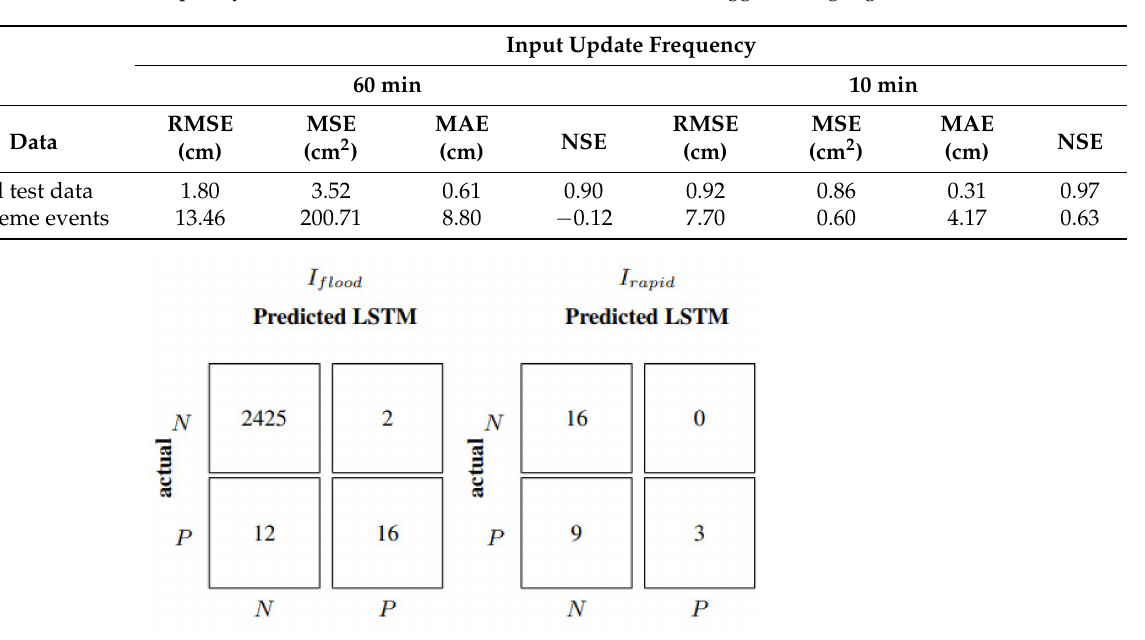
Table 8. Comparison of multivariable LSTM performances with 60- and 10-min input update frequency for the entire test dataset and flood events (Laveggio, rain gauges scenario).